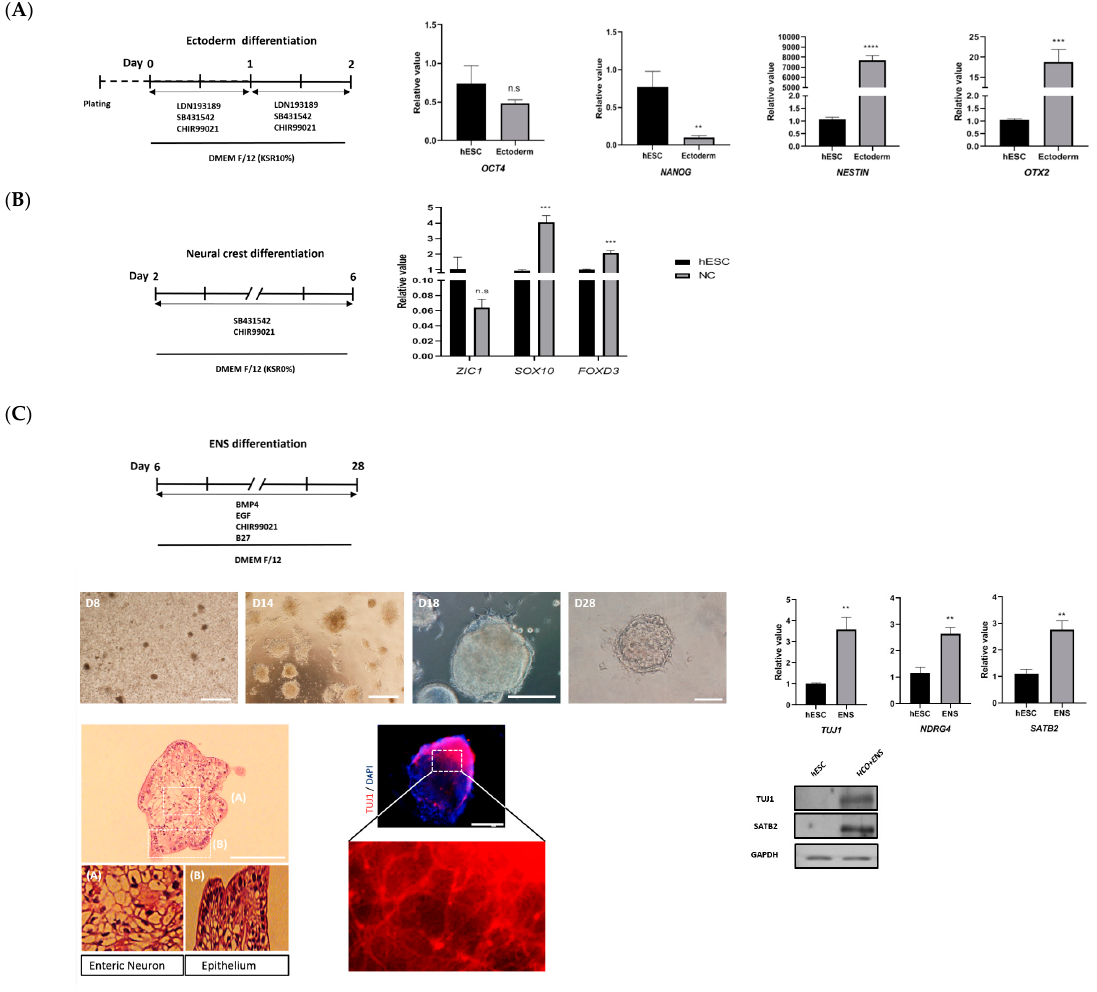
Figure 3. Development of HCOs containing ENS. ( A ) Ectoderm di ff erentiation protocol and the expression of pluripotency markers ( OCT4 and NANOG ) and ectoderm di ff erentiation markers ( NESTIN and OTX2 ) as detected via qRT-PCR. ( B ) Neural crest di ff erentiation protocol and the expression of neural crest di ff erentiation markers ( ZIC1 , SOX10 , and FOXD3 ) as detected via qRT-PCR. ( C ) Development of HCOs with ENS development protocol. Morphology of HCO containing ENS at di ff erent time points. Detection of SATB2 and TUJ1 by Western blotting, with GAPDH used as the loading control. H&E staining of HCO containing ENS, and immunofluorescent staining of of TUJ1. Expression of neuron di ff erentiation markers ( TUJ1 and NDRG4 ), and colon-specific marker ( SATB2 ) as detected via qRT-PCR. ** p ≤ 0.01, *** p ≤ 0.001, and **** p ≤ 0.0001. n.s. indicates non significance. The scale bars indicate 200 µ